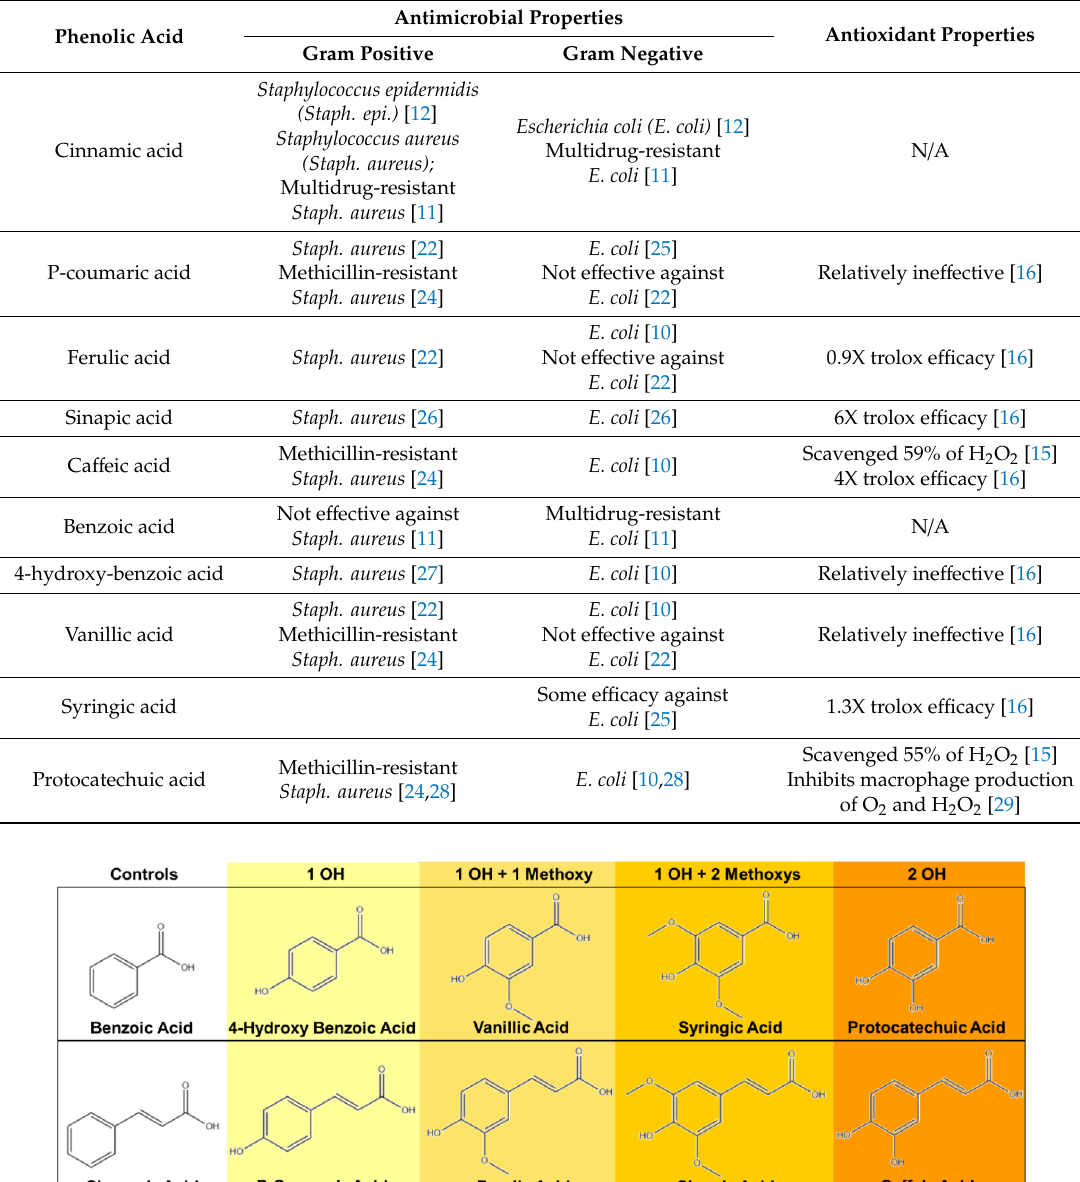
Table 1. Phenolic acid antimicrobial and antioxidant properties.